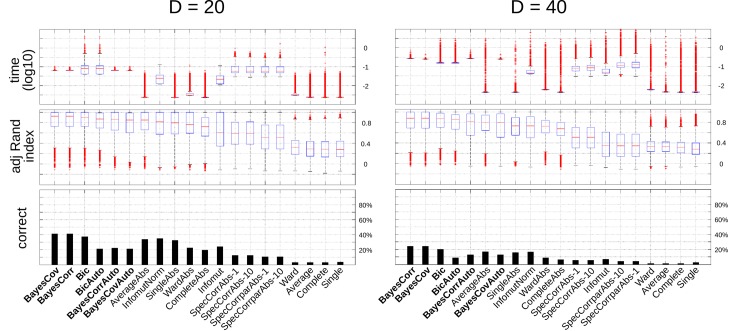
Simulation study.Computational time (top), adjusted Rand index (middle) and proportion of correct classifications (bottom) for D = 20 (left) and D = 40 (right).